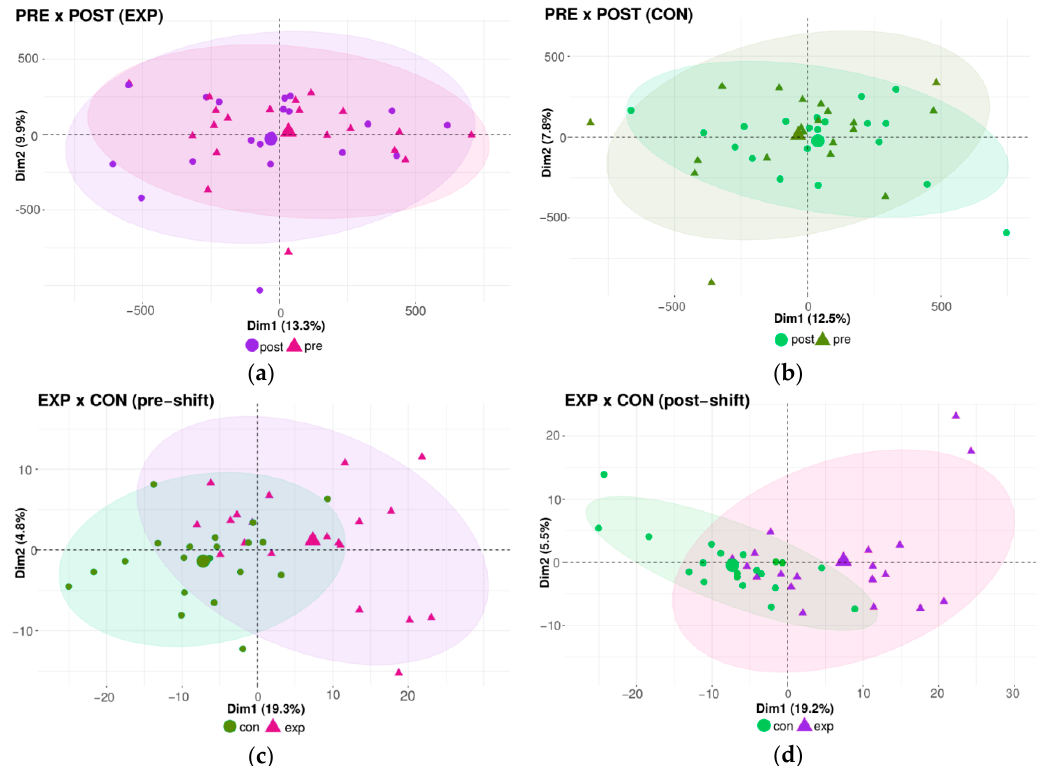
Figure 3. The impact of the nanoparticle exposure on the DNA methylation pattern; analyzed by PCA. ( a ) Comparison between exposed pre-shift and exposed post-shift groups. ( b ) Comparison between control pre-shift and control post-shift groups. ( c ) Comparison between exposed pre-shift and control pre-shift groups. ( d ) Comparison between exposed post-shift and control post-shift groups.